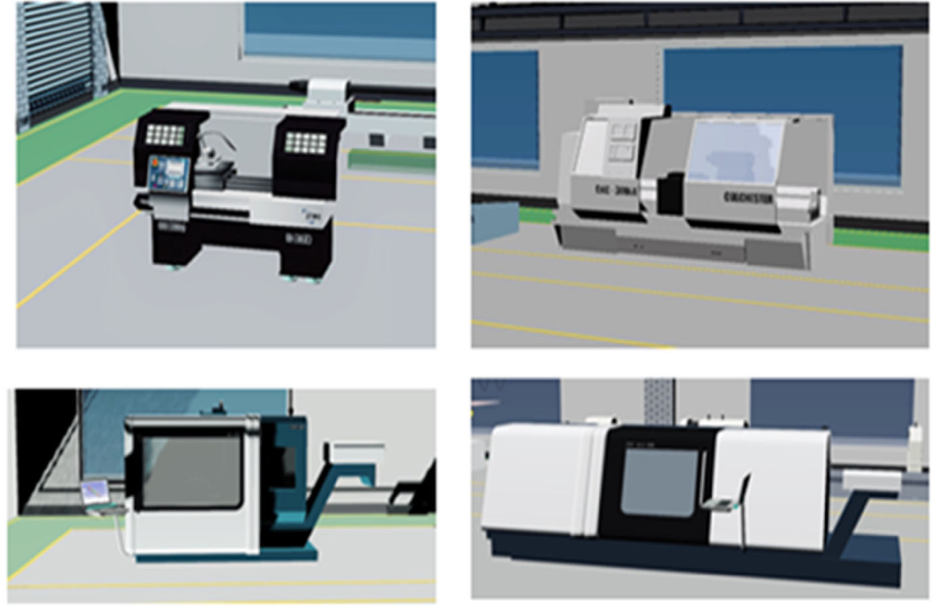
Figure 9. Presentation of the effects of the virtual scenes. (1)